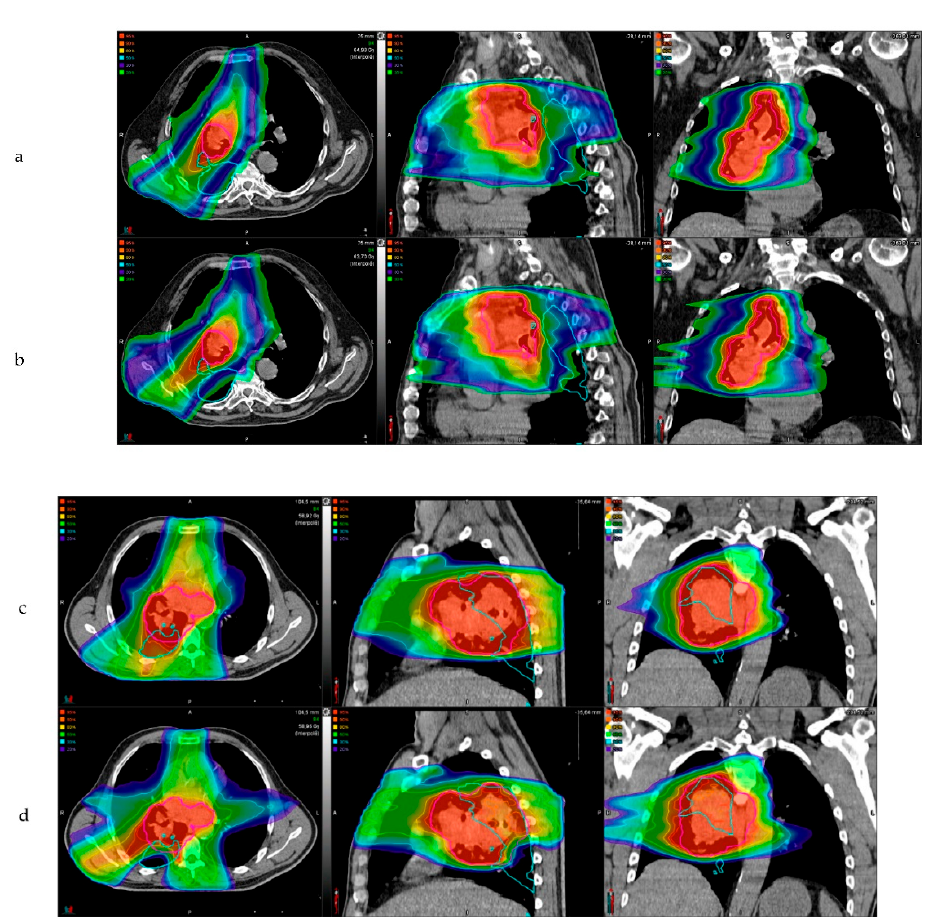
Figure 3. Examples of the initial and optimized dose maps. Abbreviations: COPD: Chronic Obstructive Disease, MEVS: Mean Expiratory Volume/Second, AJCC: American Joint Cancer Committee, PTV 95 : percentage of the planning target volume receiving 95% of the prescription dose, DMean Pmap : mean dose received by the Pmap volume, Prob APT : risk probability of acute pulmonary toxicity ≥ grade 2.